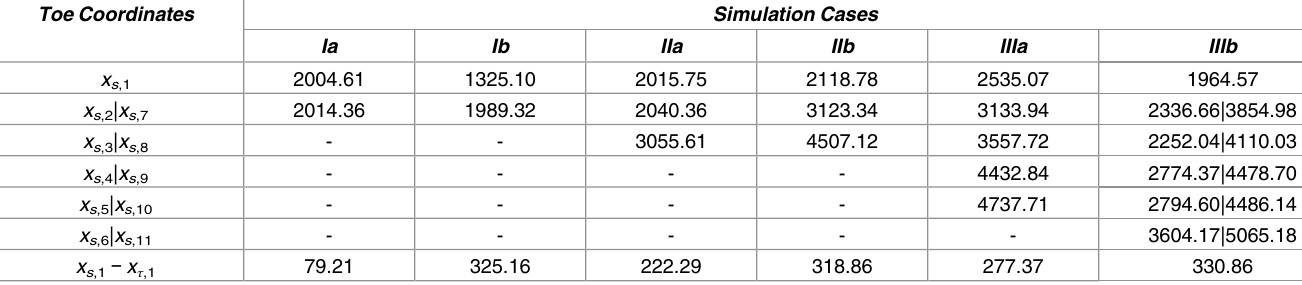
Table 8. Coordinates x s ( meters ) of the stagnation points for all simulation cases. Toe